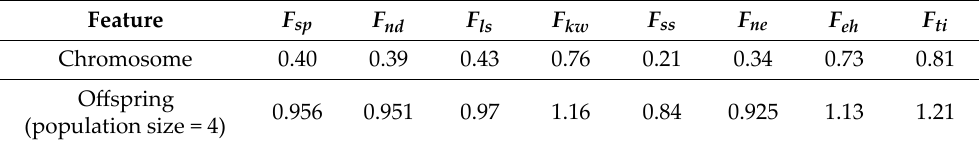
Table 5. Generated offspring after crossover operation with feature